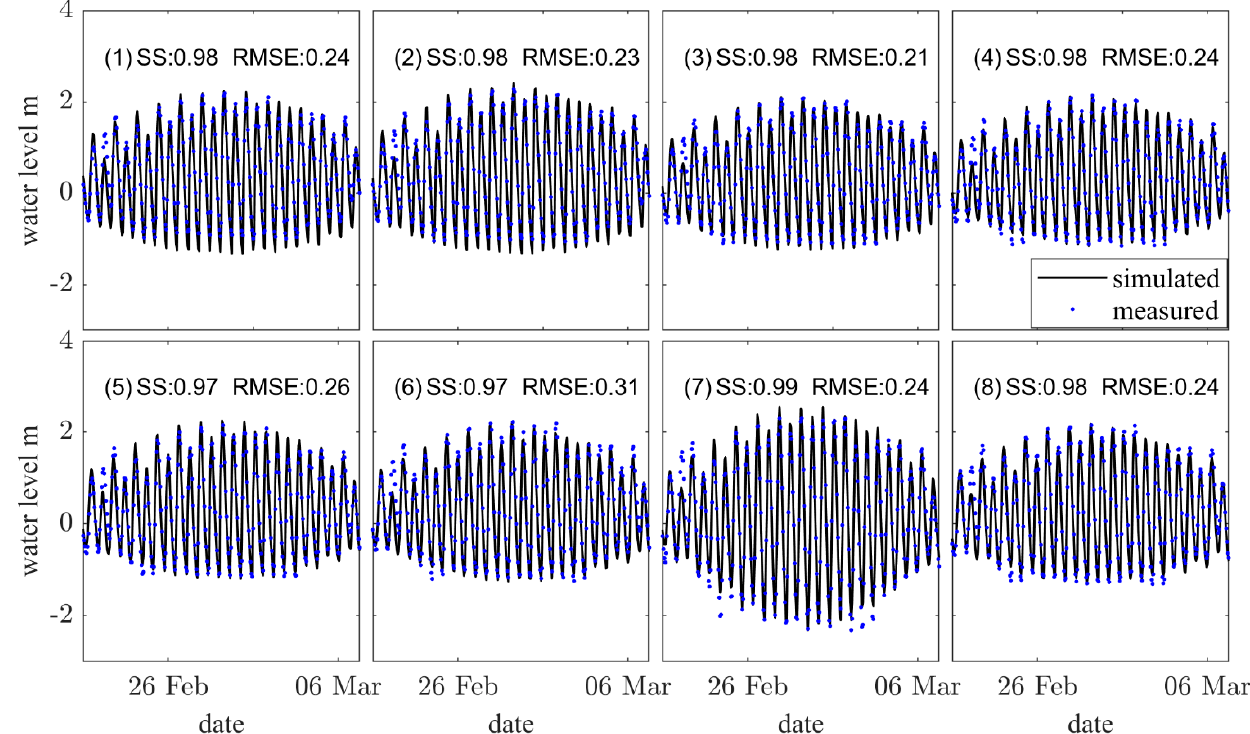
Figure 6. Model validation results for water level. (1)–(8), measured (blue dots) and simulated (black line) results at Baimao, Chongtou, Yanglin, Shidongkou, Wusong, Liuyao, Lianxinggang, and Hengsha, respectively.